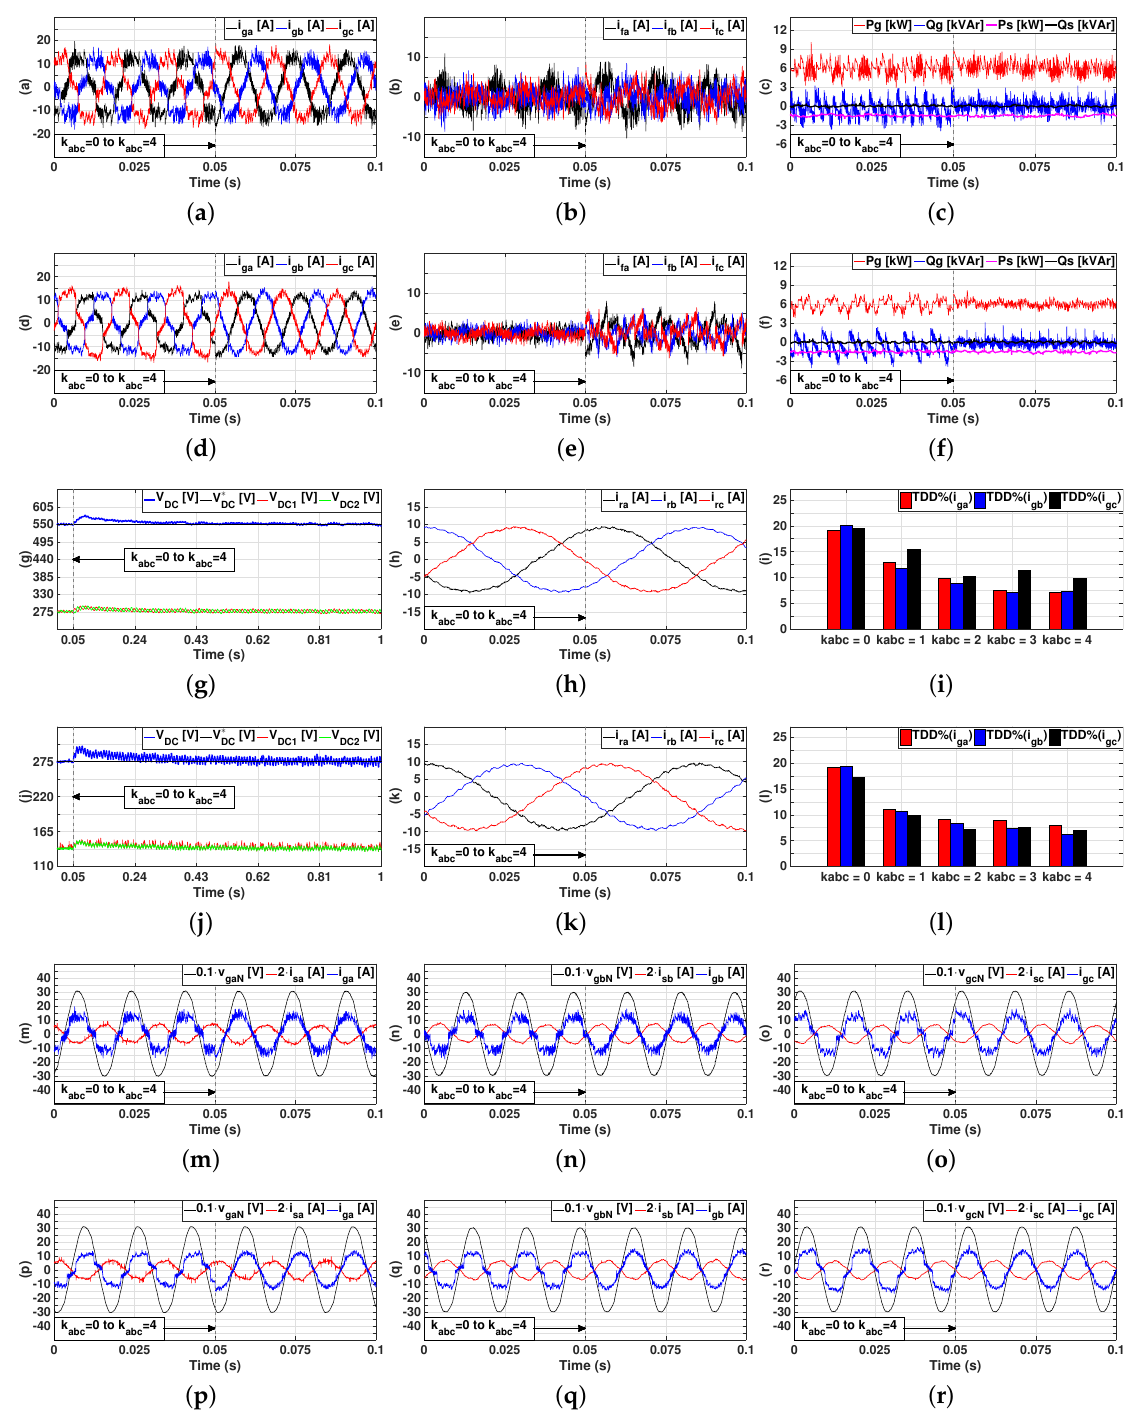
Figure 10. Experimental results for the 2L2B topology: ( a ) Grid currents; ( b ) GSC currents; ( c ) grid/stator active and reactive power; ( g ) DC-link voltages; ( h ) rotor currents; ( i ) grid currents TDD; and grid/stator currents and phase voltages in phase a ( m ), phase b ( n ) and phase c ( o ). Experimental results for the 2L3B topology: ( d ) Grid currents; ( e ) GSC currents; ( f ) grid/stator active and reactive power; ( j ) DC-link voltages; ( k ) rotor currents; ( l ) grid currents TDD, and grid/stator currents and phase voltages in phase a ( p ), phase b ( q ) and phase c ( r